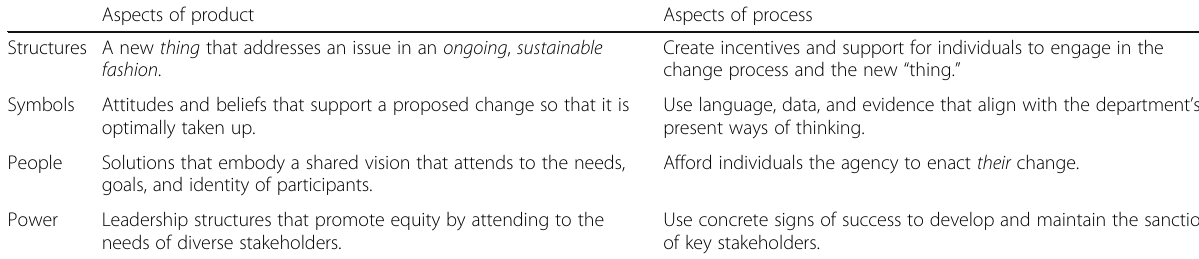
Table 1 Product and process of change as informed by the four frames Aspects of